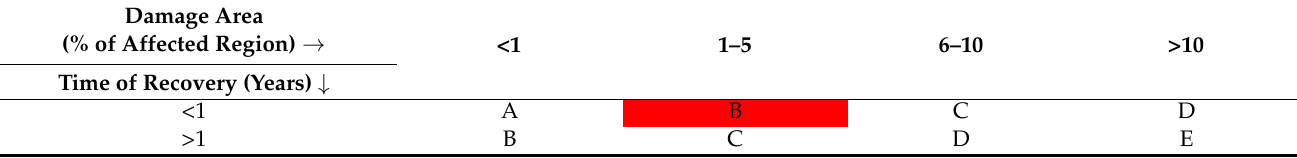
Table A5. Damage area as a percentage of the affected region [24].